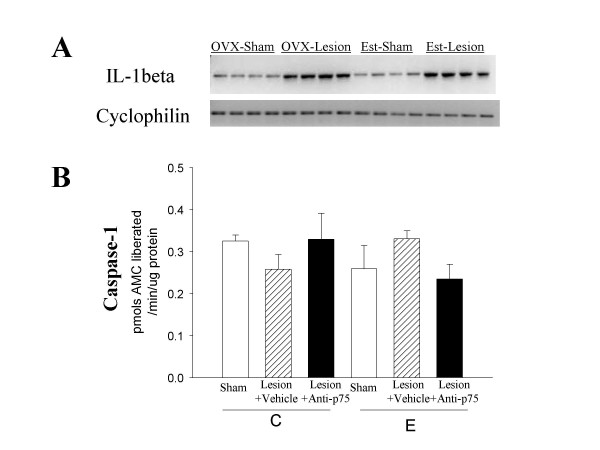
Regulation of IL-1β mRNA and the interleukin-converting enzyme: (A) mRNA from lesioned or sham injected animals, with estrogen or control pellets was reverse transcribed and amplified using primers specific for IL-1β and cyclophilin. PCR product was fractioned on an agarose gel and photographed under UV illumination. An image of these gels is shown here, with 4 representative animals from each group. At 24 h post injury, NMDA lesions increased IL-1β mRNA, however, estrogen-treated (OVX+E) animals were no different from the control-pellet (OVX) treated animals. (B) Since the mature form of IL-1β is obtained through cleavage of IL-lβ precursor protein by caspase-1, activity for this enzyme was also assayed. Neither NMDA lesions nor estrogen treatment caused any significant changes in caspase-1 activity at 24 h post injury. Histogram bars represent means ± SEM for the entire group (n = 6). *:p < 0.05.